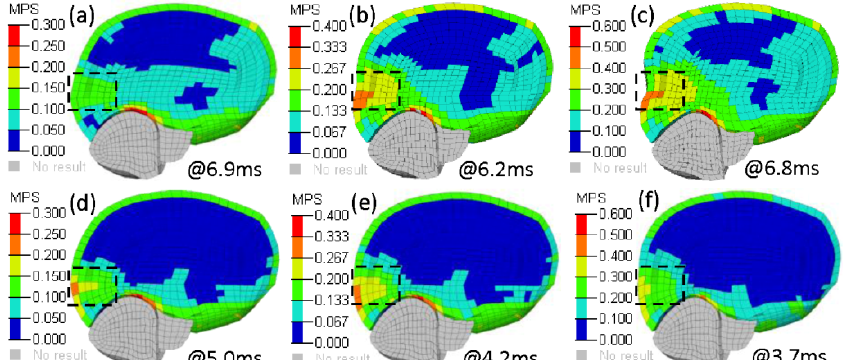
Figure 11. MPS contour for occipital impacts at three impact velocities. ( a–c ) Fracture model, ( d–f ) non-fracture model; impact velocities are 25, 35, and 45 km/h from left to right; dotted line box is at the peak MPS region of impact.